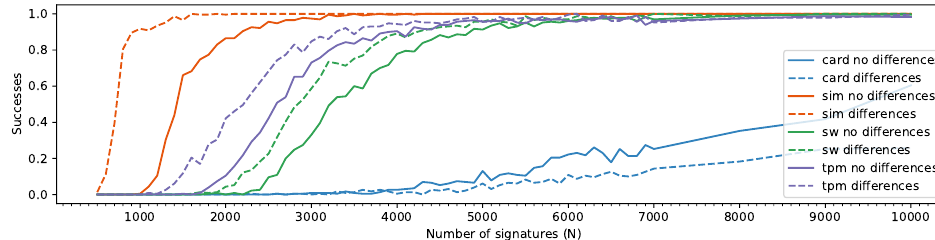
Figure 10: Success rate (averaged over all analyzed dimensions) of performing 100 random subsets from c · d fastest signatures, with c ∈ { 1 , 1 . 5 } . The more visible noise in the plot is caused by the smaller range of dimensions analysed.